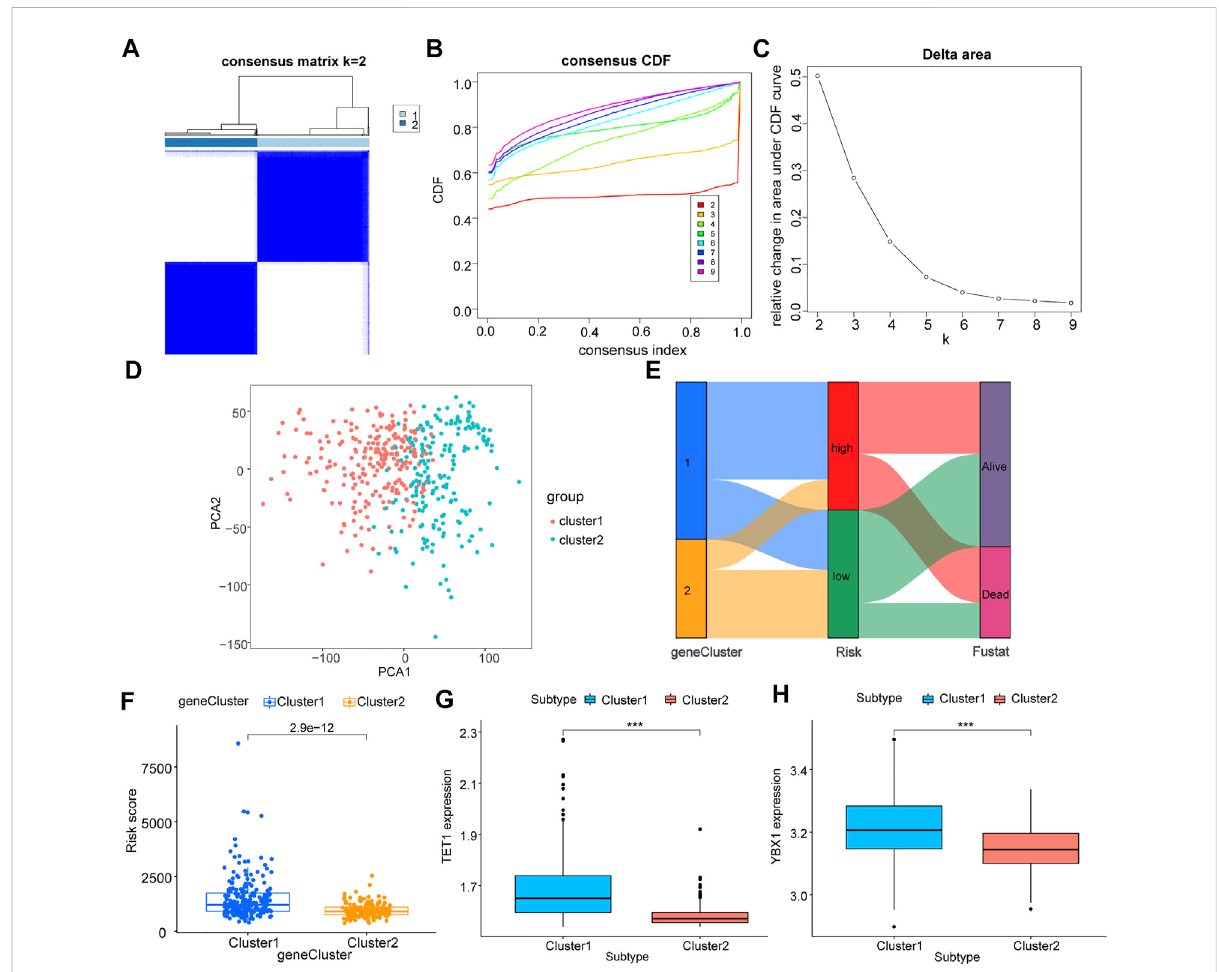
FIGURE 4 Correlation analysis of m5C regulator genes with molecular subtypes of TCGA liver cancer. All samples of TCGA were clustered according to theirexpressionlevelofm5Cregulatorgenes; (A) :samplesizeaftergrouping; (B) :changeinareaundertheCDFcurve( k =2 – 9); (C) :changeofdelta area plotwhen k = 2to k = 9;D:PCA analysis ofcluster1 and cluster2, where cluster 1is inred andcluster2 isin blue; (E) :Sankey diagram combining survival status and LASSO model grouping; (F) : difference in risk scores of different groupings, cluster 1 in blue and cluster 2 in orange; (G,H) : differential expression of key m5C regulator genes TET1 (G) and YBX1 (H) in different groupings, cluster 1 in blue and cluster 2 in